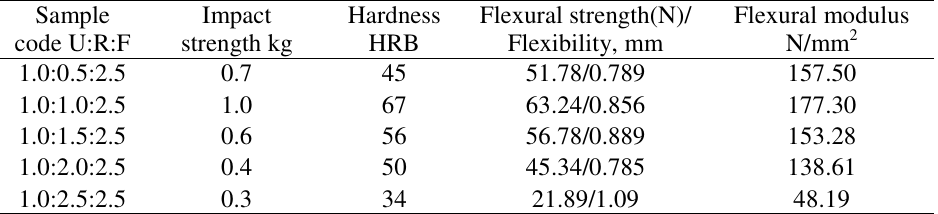
modulus for different ratios of URF resin